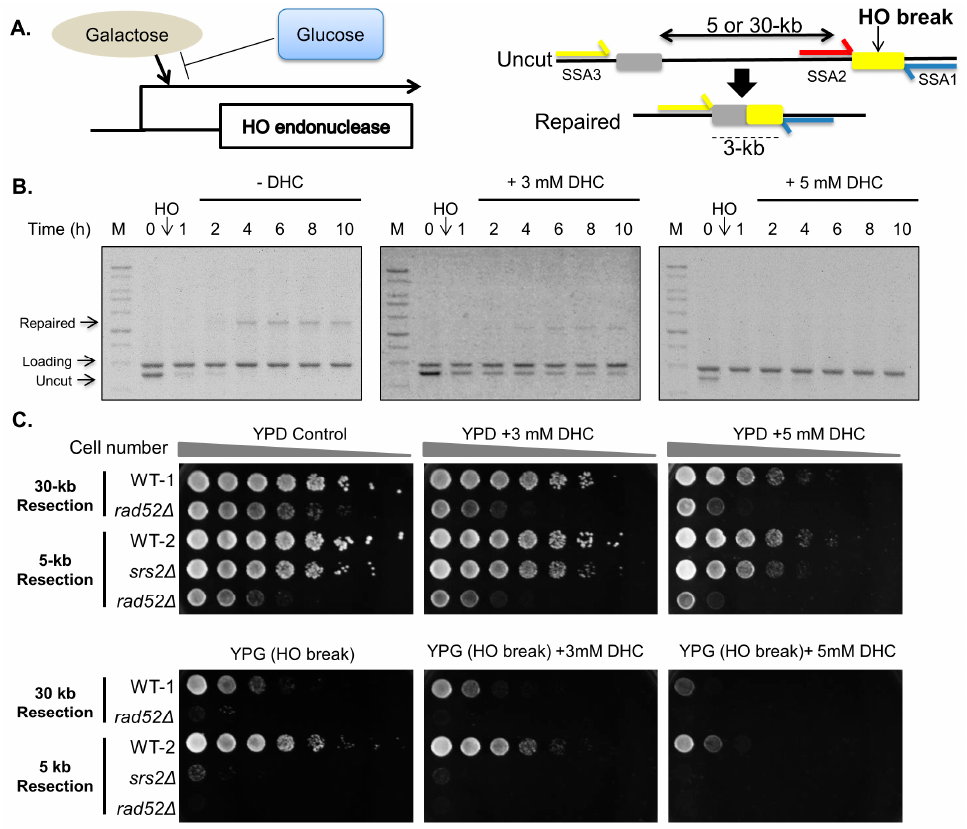
Figure 1. DHC increases DNA damage sensitivity and inhibits DNA double-strand break repair in SSA strains. ( A ) Schematic diagram of the single strand annealing (SSA) system. Galactose was used to induce HO endonuclease and thus generate a specific HO lesion. Repair of the HO lesion at the HO cleavage site (yellow box) requires a 5-kb or 30-kb resection back to the uncleavable HO cleavage site (gray box). Three polymerase chain reaction ( PCR) primers (SSA1, SSA2 and SSA3 primers) were used for measuring DNA damage and repair; ( B ) DHC inhibits DNA double-strand break repair in the 5-kb resection strains (YMV045). The DSB was induced by the addition of galactose to the YMV045 strain. After 30 min, the cultures were treated with 3 mM or 5 mM DHC, and the repair of the HO lesion was analyzed by PCR. The marker is labeled M; ( C ) Five-fold serial dilution analysis of WT-1 (YMV002), rad52 ∆ (YMV037), WT-2 (YMV045), srs2 ∆ (YMV057), and rad52 ∆ (YMV046) shows sensitivity to galactose and DHC. The cells were allowed to grow at 30 °C for 3 days and were photographed for recording colony formation.